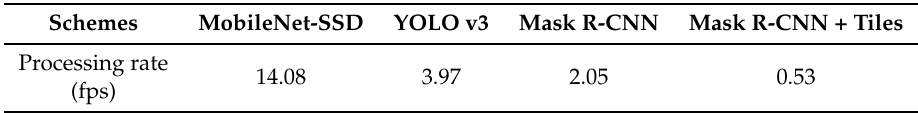
Table 2. Processing rate of four